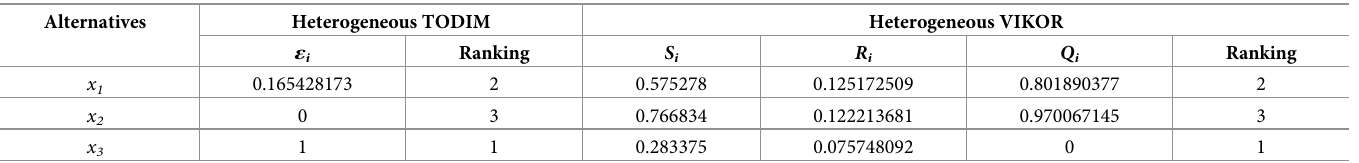
Table 12. Ranking